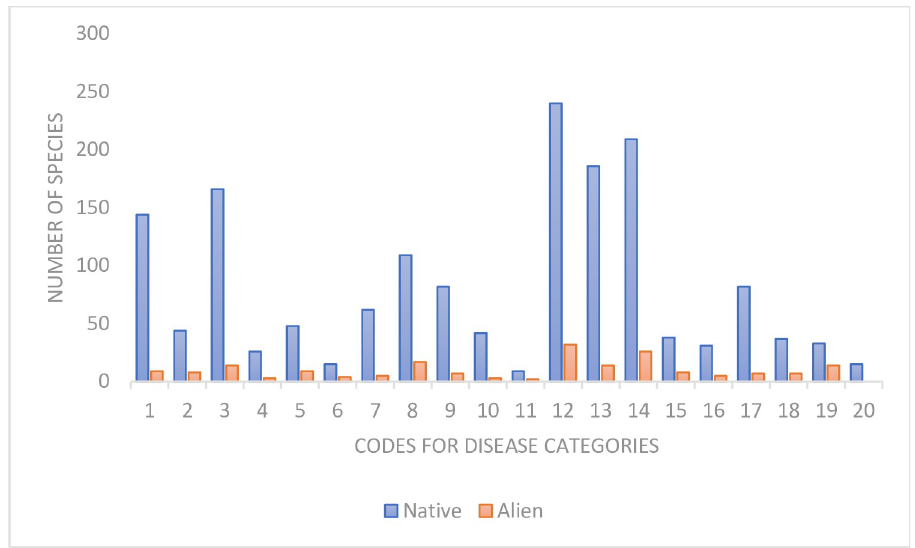
Fig 2. Number of species used in the treatment of different diseases. Disease categories are as follows: 1. Headache_Nervous_Mental_Disease, 2. Oral_Dental_Diseases, 3. Body_Pain_Killer_Anti_Inflammatory, 4. Kidney_Diseases, 5. Fever_Malaria; 6. Diabetes; 7. Burns_Wounds_Injury_Scars; 8. Respiratory_Diseases; 9. Skin_Diseases; 10. Eye disease; 11. Ear disease; 12. Parasitic_Infection_Control; 13. Gastrointestinal diseases; 14. Obstetrics_Gynaecology_Diseases; 15. cardiovascular diseases; 16. Growth disorders; 17. Blood disorder; 18. Anti_Venom_Poison; 19. HIV/AIDS; 20. Cancer.